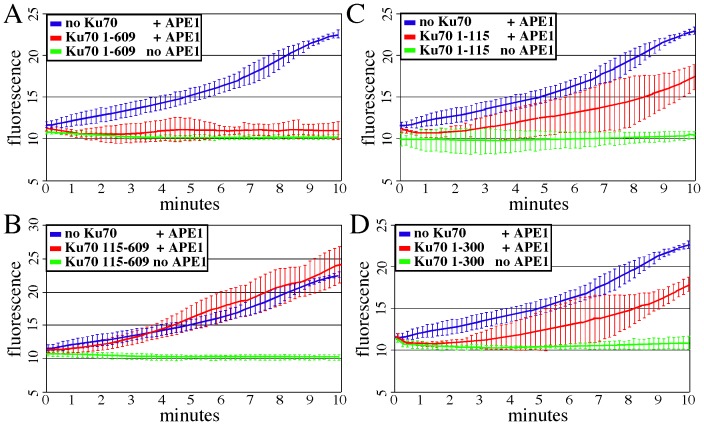
Molecular beacon assay to measure APE1 activity.No Ku70 was compared to Ku70 added to substrate with or without APE1. Fluorescence: the excitation wavelength is 485 nm and the emission wavelength is 538 nm. Shown is the average of three experiments with error bars (standard deviation). (A) Ku701–609 (full-length Ku70) (B) Ku70115–609. (C) Ku701–115. (D) Ku701–300.